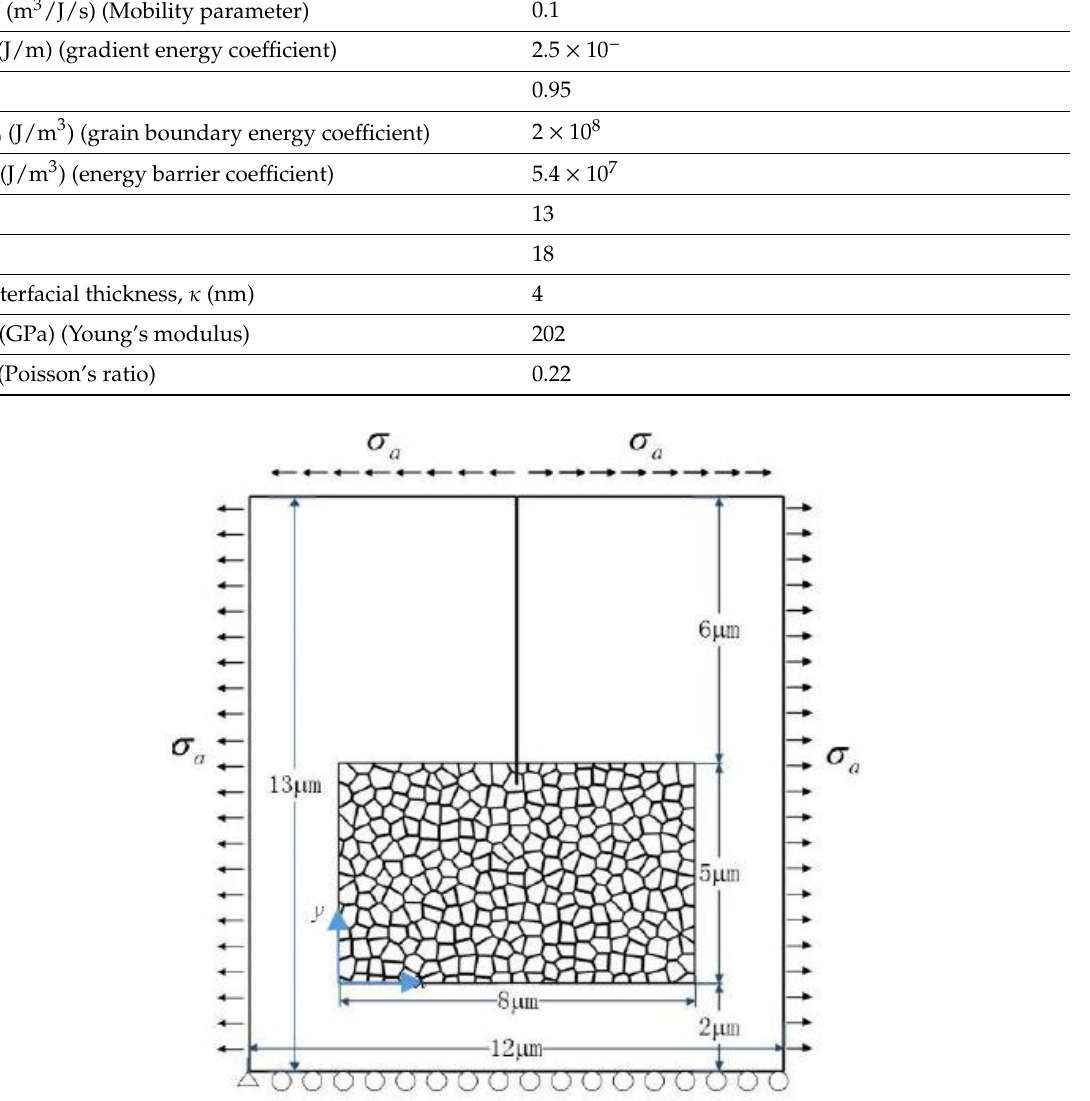
Table 1. Deformation gradient ( ij F ), right stretch tensor ( ij U ), and transformation strain ( 00 ij  ) of the monoclinic variants [66].